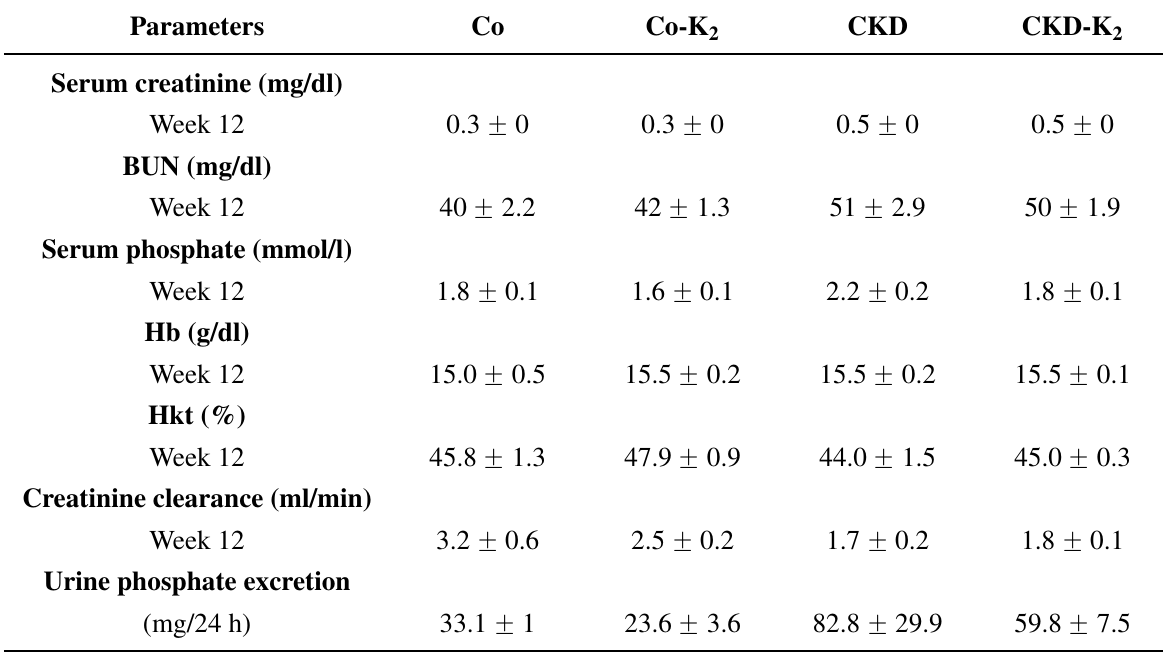
Table 2. Serum and urine parameters after 12 weeks of study